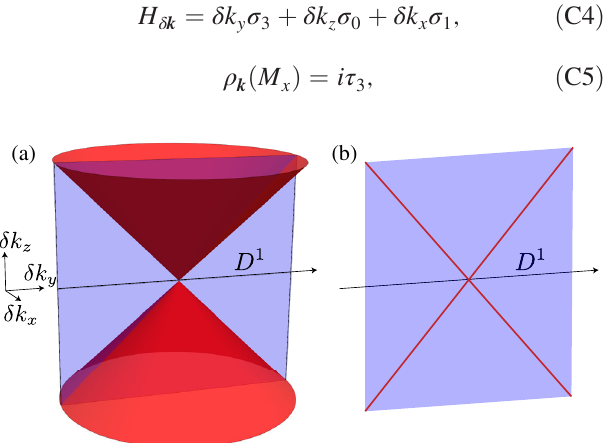
FIG. 19. Nodal structures for effective low-energy models in Eqs. (C1) and (C4). The blue planes represent the mirror invariant planes, and red cones in (a) and the red lines in (b) are surface nodes for Eq. (C1) and line nodes for Eq.